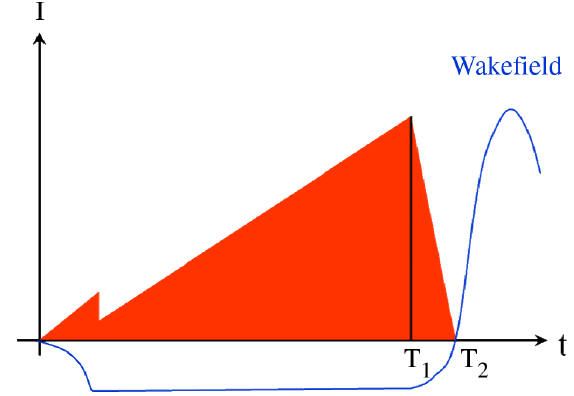
FIG. 2. Illustration of the double-triangular bunch with a drop- ping tail and its wakefield.